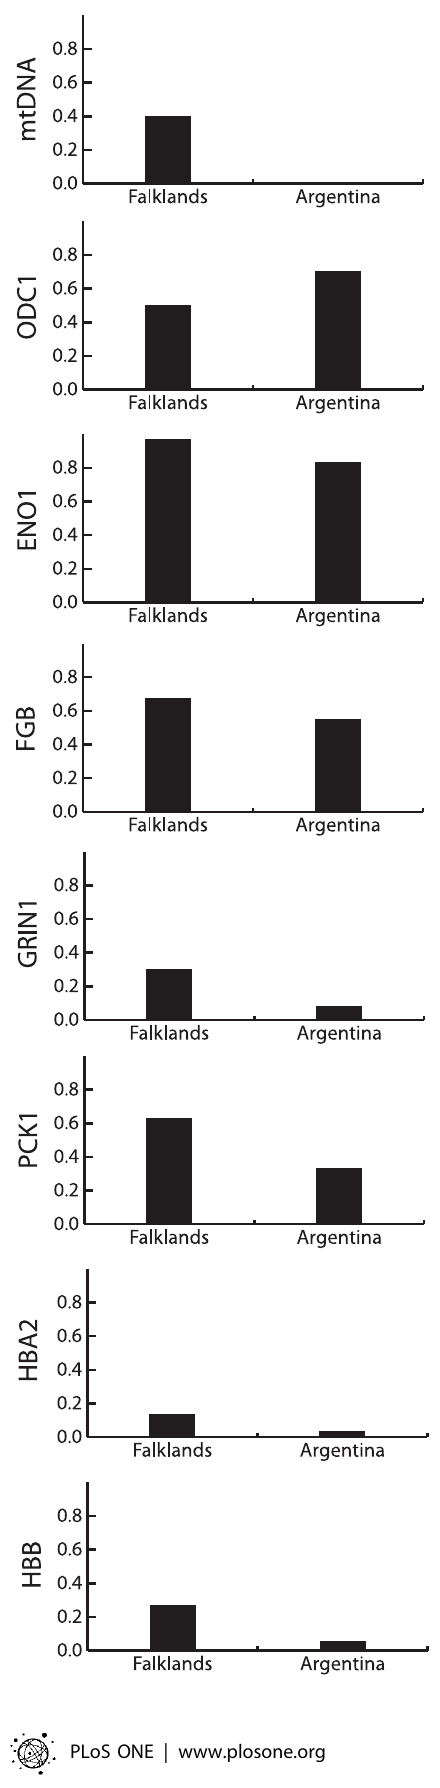
Figure 6. Frequency of the most common speckled teal allele in the Falkland Islands and